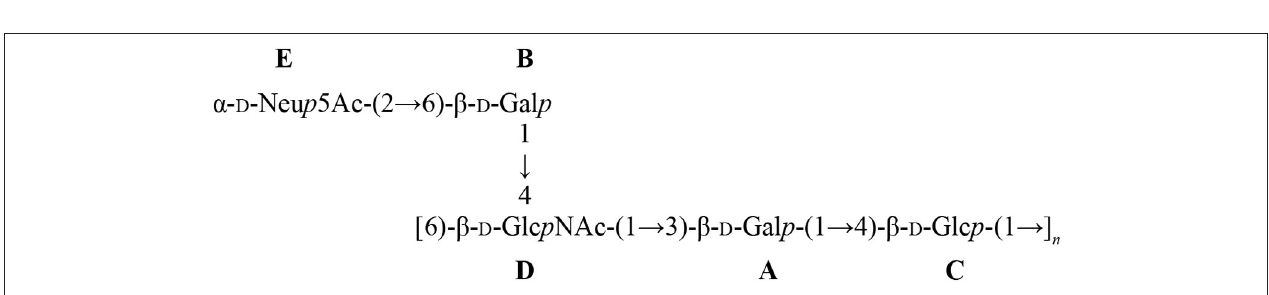
Frontiers in Microbiology |